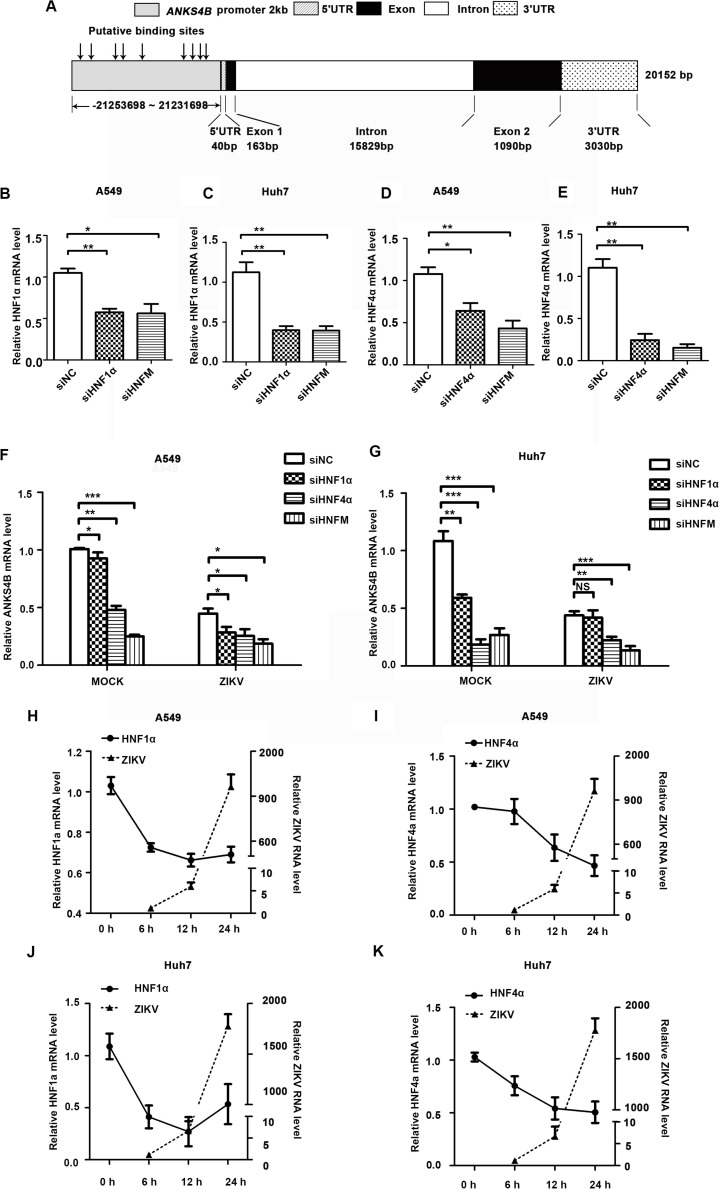
Reduction of ANKS4B by ZIKV infection was dependent of HNF1α and HNF4α. (A) Putative HNF1α and HNF4α binding sites in the promoter region of ANKS4B. (B–G) Effect of HNF1α and HNF4α knockdown on ANKS4B level. A549 cells and Huh7 cells were transfected with siNC, siHNF1α, siHNF4α, or siHNFm (mixture of siHNF1α and siHNF4α). At 48 h post-transfection, cells were harvested for qRT-PCR to detect the levels of HNF1α
(B,C), HNF4α
(D,E), and ANKS4B
(F,G). (H–K) qRT-PCR to detect HNF1α and HNF4α levels in A549 (H,I) or Huh7 (J,K) cells. Cells were infected with ZIKV (MOI 3), and collected at indicated time points for qRT-PCR. GAPDH level was set as an internal control. Relative RNA levels were calculated over the RNA level measured at 0 h p.i. All the data were shown as means ± S.D. (error bars) from at least three independent experiments. NS, not significant; *p < 0.05; **p < 0.01; ***p < 0.001; unpaired, two-tailed Student’s t-test.